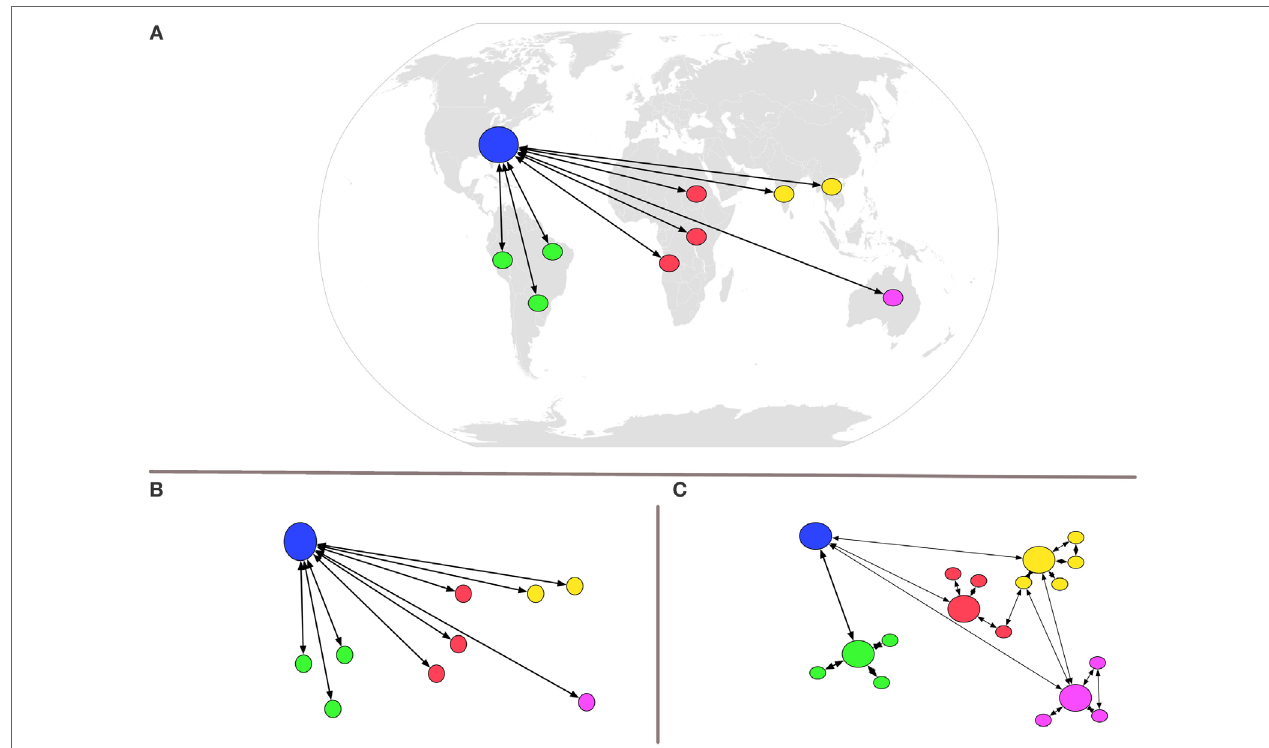
FigUre 3 | Visual representation of new opportunities enabled by multiplayer screen-based simulation. Because the software runs on readily available computers, screen-based simulation enables new opportunities for global health, including just-in-time education from the USA to anywhere (a,B) or anywhere to anywhere (c) . Configurations such as those noted in Figure 3c , since they require no more than a computer and Voice-over-IP headset, may be scaled to a global audience relatively quickly.